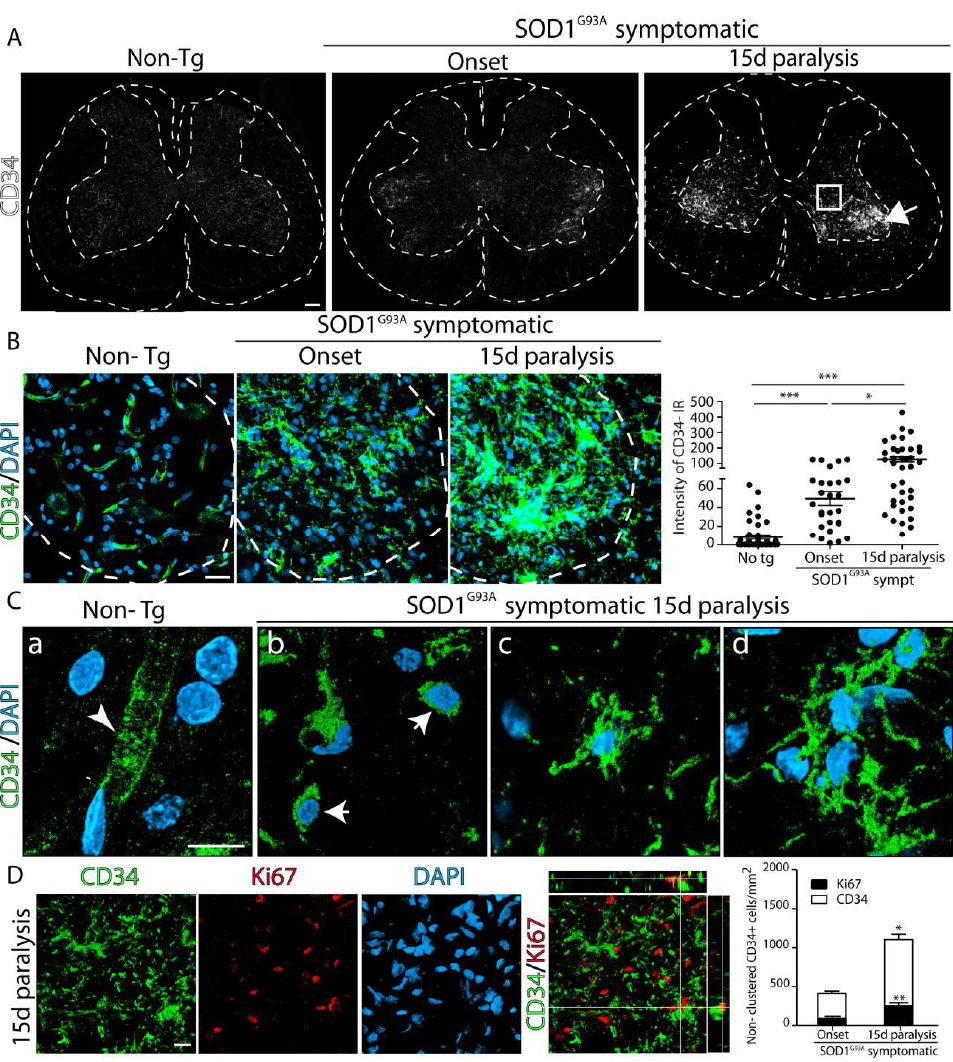
Figure 1. CD34 + immunoreactivity in the degenerating spinal cord during the course of paralysis in SOD1 G93A rats. Representative confocal microscopy images showing the expression of CD34 in the spinal cord of Non-transgenic (Non-Tg), SOD1 G93A -onset, and SOD1 G93A -15d paralysis rats. ( A ) Confocal tile reconstruction of the spinal cord showing increasing CD34 expression (white) in the ventral horn. The arrow and square indicate CD34 distribution in clustered and non-clustered cells, respectively. ( B ) Representative confocal images of CD34 expression (green) showing the detailed distribution of CD34 + cells in the ventral horn. Note CD34 staining in Non-Tg spinal cord was restricted to blood vessels while an increased immunoreactivity and different distribution was noted in SOD1 G93A rats. Dotted lines show the limit between grey and white matter in the lumbar cord. The graph to the right shows the quantitative analysis of CD34 immunoreactivity among groups. Quantitative data are expressed as mean ± SEM; data were analyzed by Kruskal–Wallis followed by Dunn’s multiple comparison test, * p < 0.05, *** p < 0.001 was considered statistically significant ( C ) Representative confocal images showing the di ff erent CD34 + cell phenotypes present in non-clustered regions. a) Blood vessels in Non-Tg animals. b) Two round cells. c) Ramified cell. d) Small cluster of three cells. ( D ) Confocal images showing proliferating CD34 + cells in non-clustered regions stained with Ki67. Orthogonal view shows Ki67 + nuclei on the CD34 + cell. The graph to the right shows the quantitative analysis of non-vascular CD34 + and CD34 + / Ki67 + cells in non-clustered regions. Quantitative data are expressed as mean ± SEM; data were analyzed by Mann-Whitney test, * p < 0.05, ** p < 0.01 was considered statistically significant. n = 4 animals / condition. Scale bars: 100 µ m ( A ), 25 µ m ( B ), and 10 µ m ( C,D